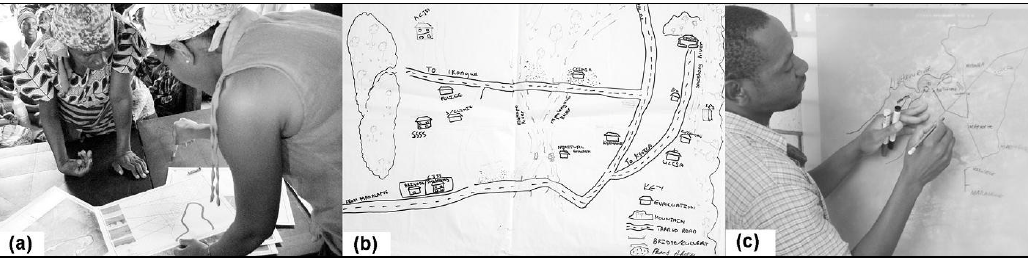
(Photographers: ( a ) Fernando Ferreiro, ( b ) Tiego Mpho, ( c ) Herman